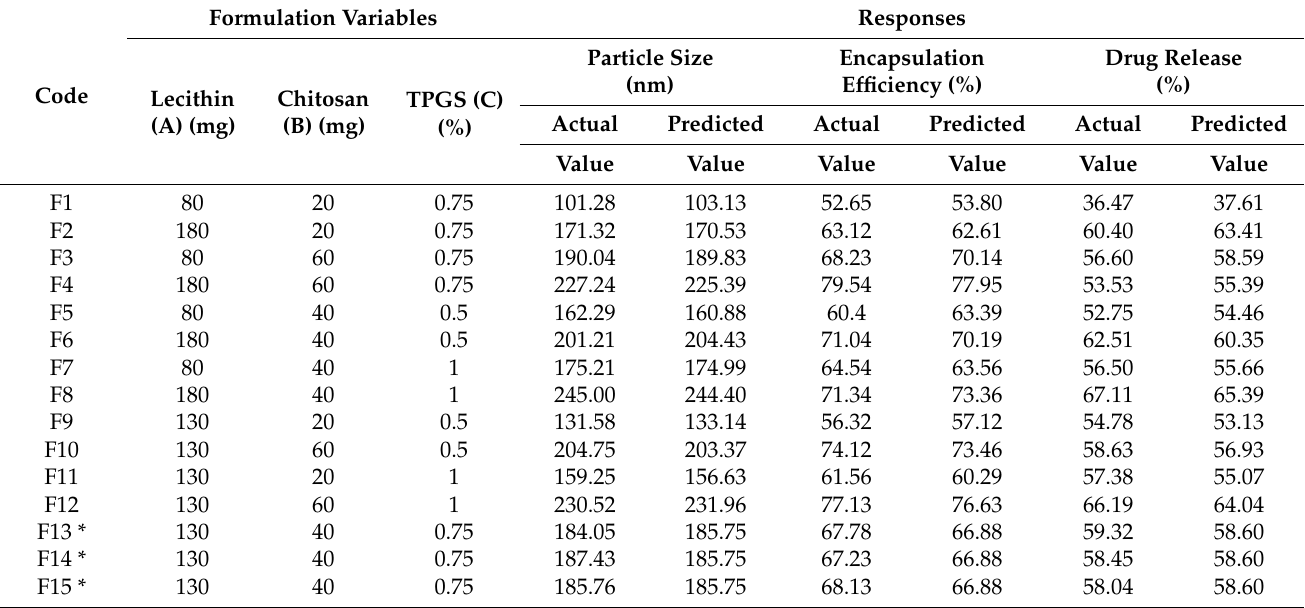
Table 1. Formulation composition of Apigenin-loaded hybrid nanoparticles and their effects on particle size, encapsulation efficiency and drug